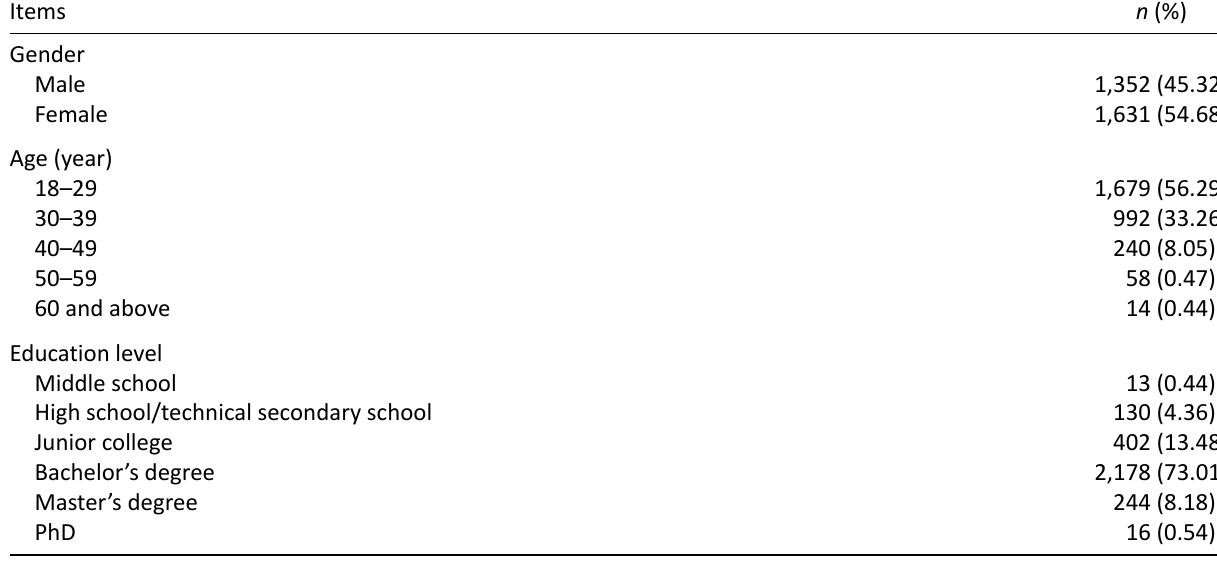
Table 4. Socio‐demographic Information of the respondents ( N =